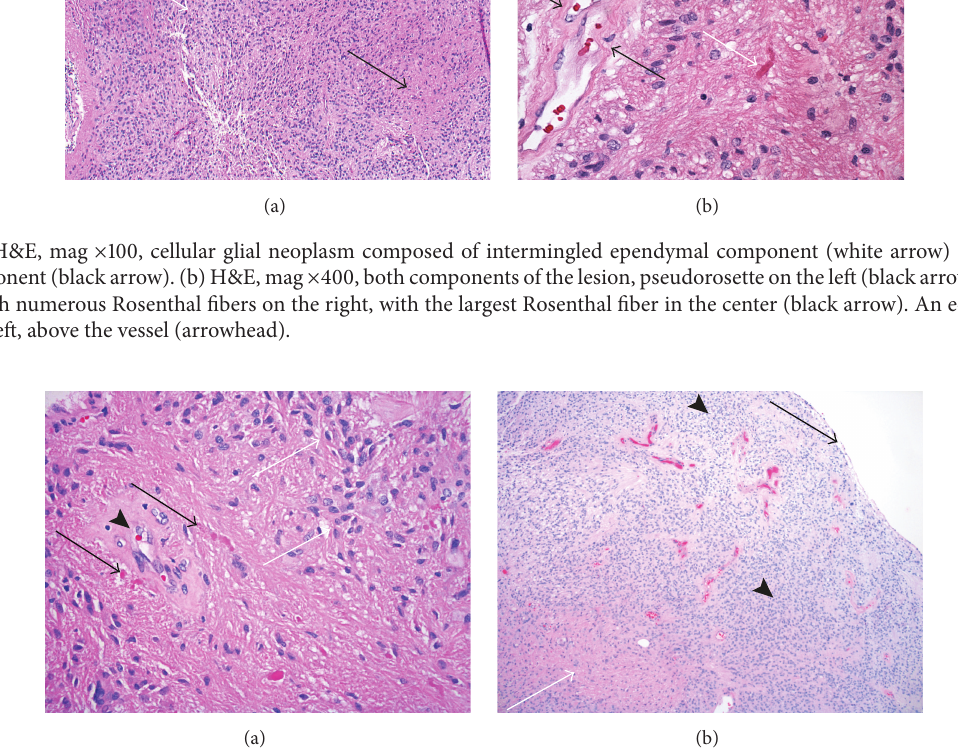
Figure 4: (a) H&E, mag × 400, bright eosinophilic deposits (black arrows) representing Rosenthal fibers in astrocytic component admixed with ependymal component (white arrows), adjacent to pseudorosette formation (arrowhead). (b) H&E mag × 40, pseudocapsule (black arrow) with exclusively ependymal component at periphery of the lesion (arrowheads); astrocytic component is in the center (white arrow).